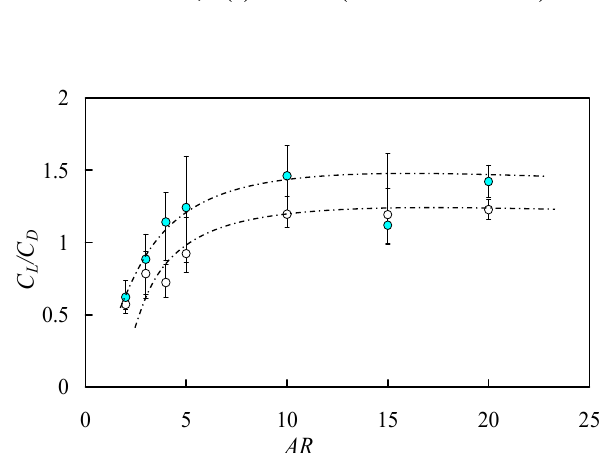
Fig. 10 Lift-to-drag ratio C L /C D versus aspect ratio AR at depth-to-width ratio λ = 0.3, C = 3.86 × 10 2